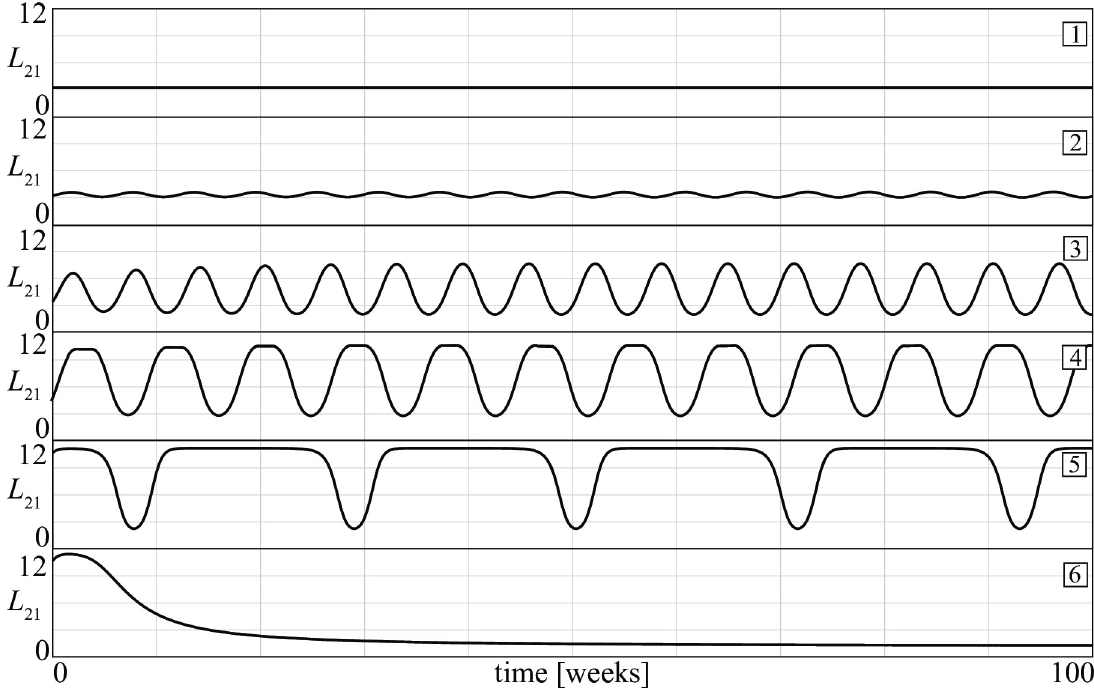
Fig 10. Time patterns of losses L 21 in six different D—A conflicts (see points 1, ... , 6 in Fig 7).